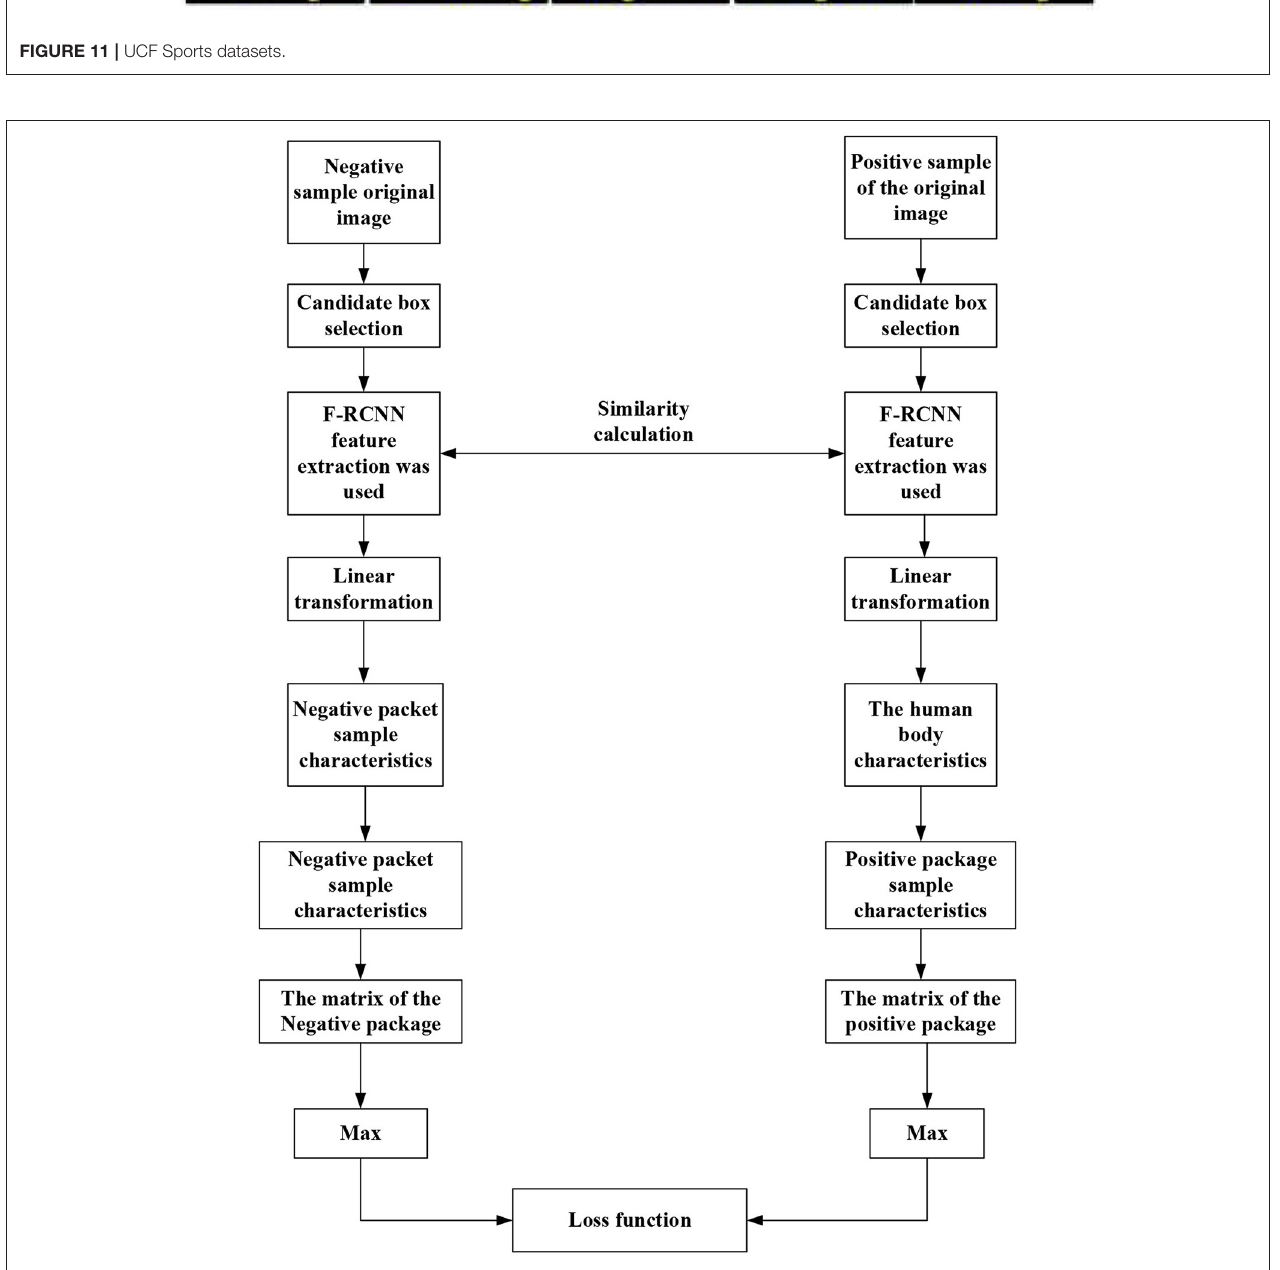
FIGURE 12 | Target detection frame of